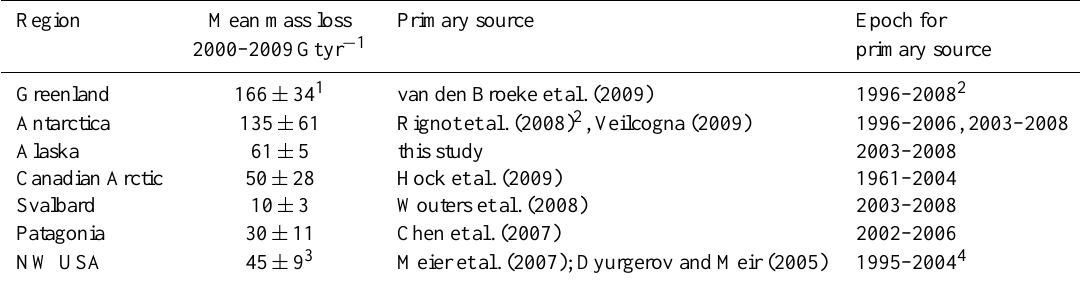
Table 1. Regional distribution of ice mass losses for 2000–2008 inclusive. Column three refers to the primary source for relative spatial distribution of losses. The uncertainties quoted in column 2 are scaled values obtained from the source text, where available. They are scaled so that the ratio of the error vs. mass trend is the same here as in the original cited reference. They do not indicate our assessment of the uncertainty in mass trends from each source and may be an underestimate of this. For mountain glaciers and ice cap regions the source references were not always explicit about the relative contributions. For NW USA we referred to Dyurgerov and Meier to determine the relative contributions but ensured that the total for non-ice sheet contributions agreed with Meier et al., 2007 and Dyurgerov and Meier, 2005. Our estimates for Greenland and Antarctica include MG&IC not connected to the ice